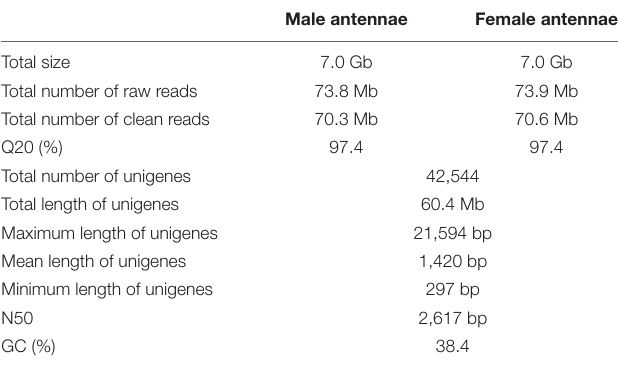
TABLE 1 | Information of the G. mellonella antennal